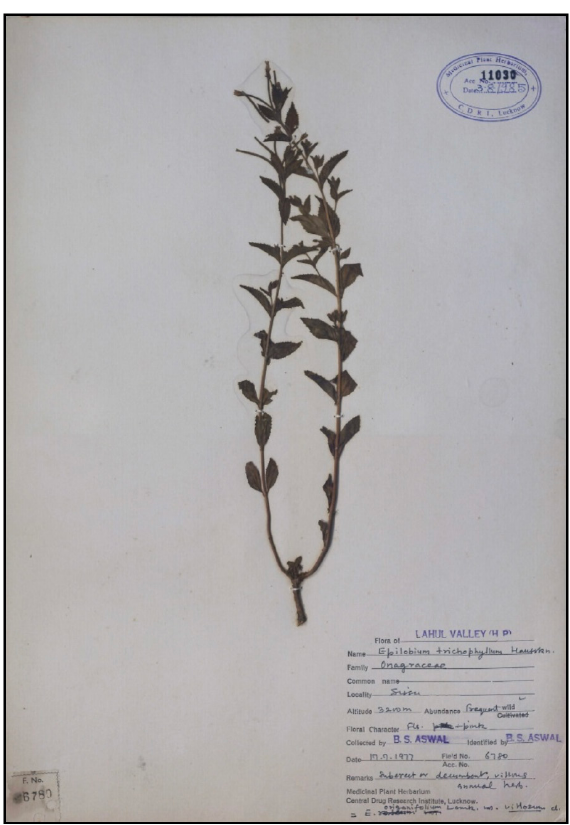
Flowers suberect. Petals pink. Stigma clavate/ capitate